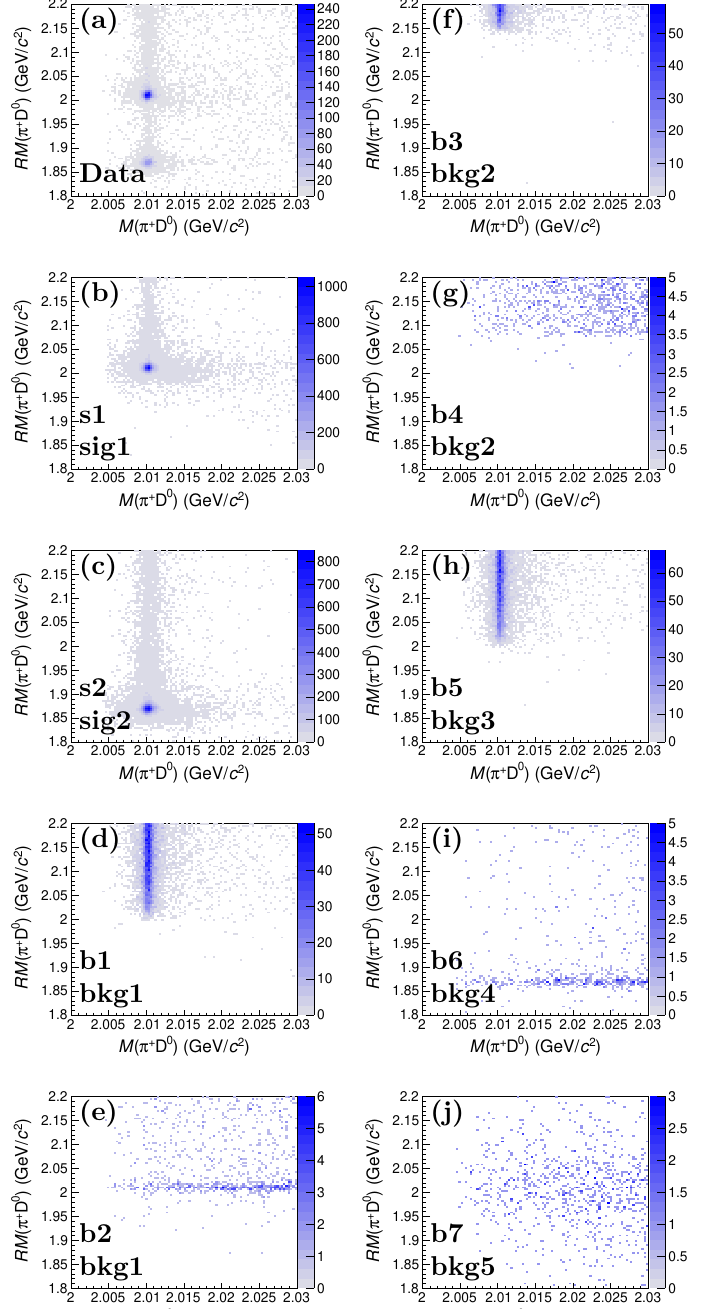
Figure 1. Distributions of the recoil mass RM ( π + D 0 ) versus the invariant mass M ( π + D 0 ) for (a) data, and the MC-simulated processes (b) e + e − → D ∗ + D ∗− , (c) D ∗ + D − , (d) D ∗ + ¯ D 0 π − , (e) D ∗− D 0 π + , (f) D ∗ + ¯ D ∗ 0 π − , (g) D ∗− D ∗ 0 π + , (h) D ∗ + D − π 0 , (i) D − D 0 π + , and (j) D ∗ 0 ¯ D ∗ 0 at 4.416 GeV c.m. energy, where plots (b) and (c) are the signal processes, and plots (d-j) are the background processes in this analysis. Labels of s1, sig1, b1, bkg1 etc. are used in eq. (4.1) and described in